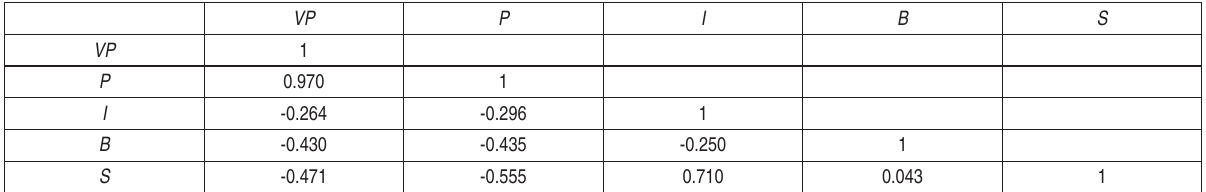
Table 3. The matrix coefficients of pair correlation to calculate the volume of loans granted by banks